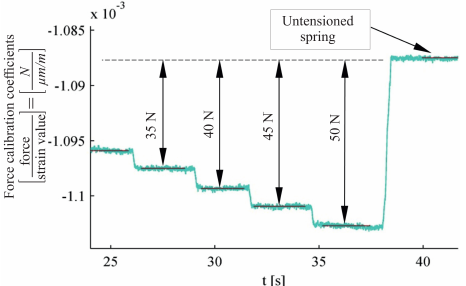
Figure 6. Measured sign (blue) and averaged values (red lines) of force